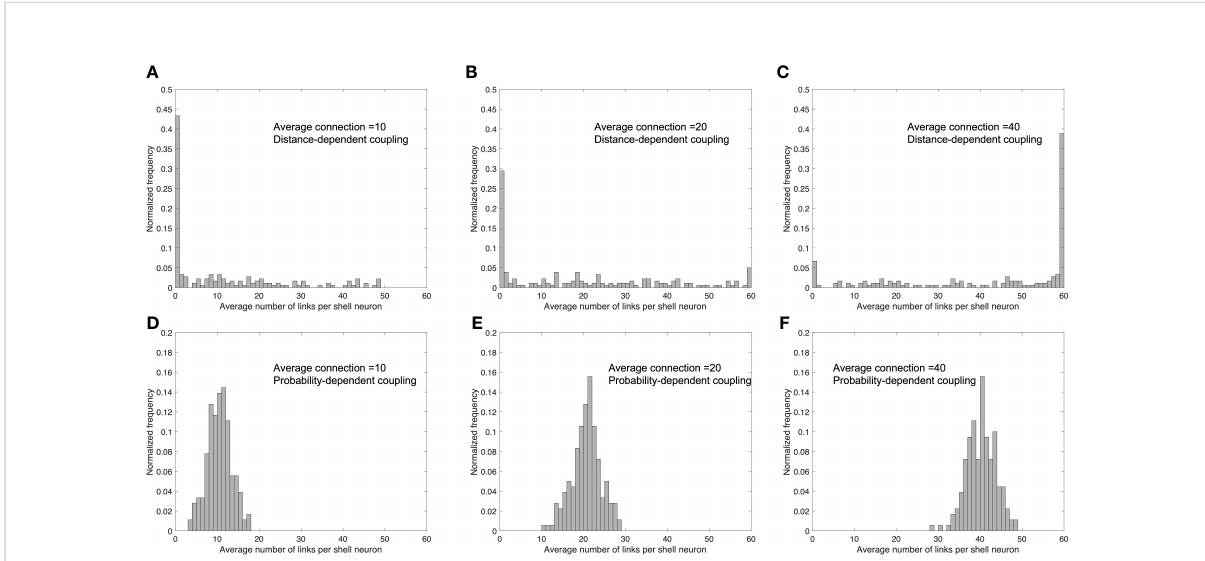
FIGURE 5 Distribution of the number of links per shell neuron in distance-dependent and probability-dependent networks under different values of the average number of links per shell neuron. Average link number=10 (A, D) ; average link number=20 (B, E) ; average link number=40 (C, F) . (A – C) are simulated under a distance-dependent network, while (D – F) were simulated under a probability-dependent network. Compared to the biased distribution in the distance-dependent coupling network, the probability-dependent network adopts a more uniform distribution, resulting in more cells in the shell receiving a moderate number of coupling signals from the core.